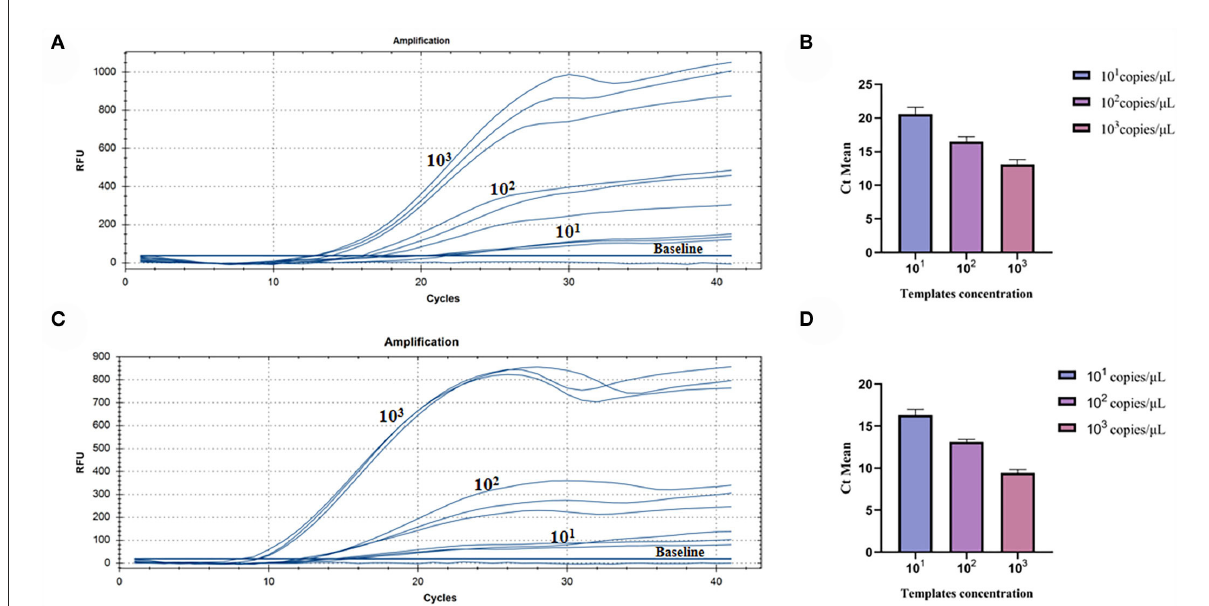
FIGURE5 Assay for the RT-RAA repeatability: (A) Three low-concentration gradients of the pure plasmid standards were measured, each repeated three times: 10 1 , 10 2 , and 10 3 copies/ µ l. (B) Data from three runs of pure plasmid standards to analyze real-time RAA assay. (C) Three low-concentration gradients of the complex plasmid solutions were measured, each repeated three times: 10 1 , 10 2 , and 10 3 copies/ µ l. (D) Data from three runs of complex plasmid solutions to analyze real-time RAA